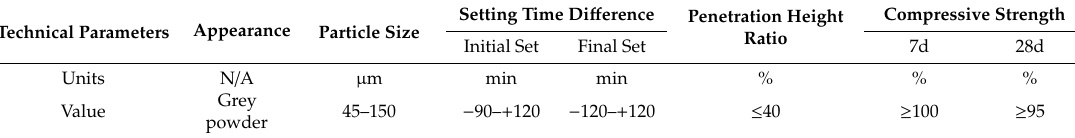
Table A5. Technical parameters of DMC-S-WS-710B cementitious capillary crystalline active masterbatch (CCCAM).